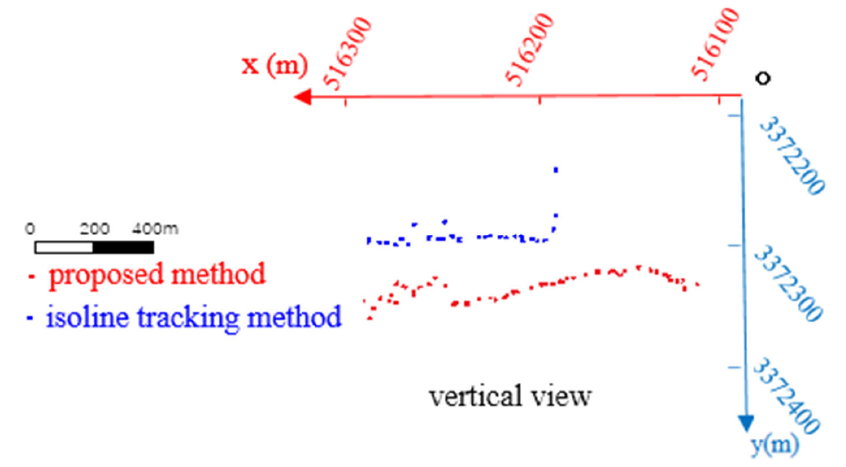
Figure 15. The superposition of this method and isoline tracking method. The superimposed display of the coastline point clouds calculated using the proposed method and the isoline tracking method and the point cloud of the cliff segment are presented in Figure 16a. Points in the red box, that is, green points, were calculated with the isoline ‐ tracking method. In the figure, the green points will be projected into the water surface, so the red and green points are approximately in the same plane, and their elevations are close. Figure 16b shows the superposed display of coastlines generated based on the two types of points and point clouds of the cliff section. The green coastline shows a large error and a large deviation from the actual trend, whereas the red coastline is smoother, continuous, and closer to reality.